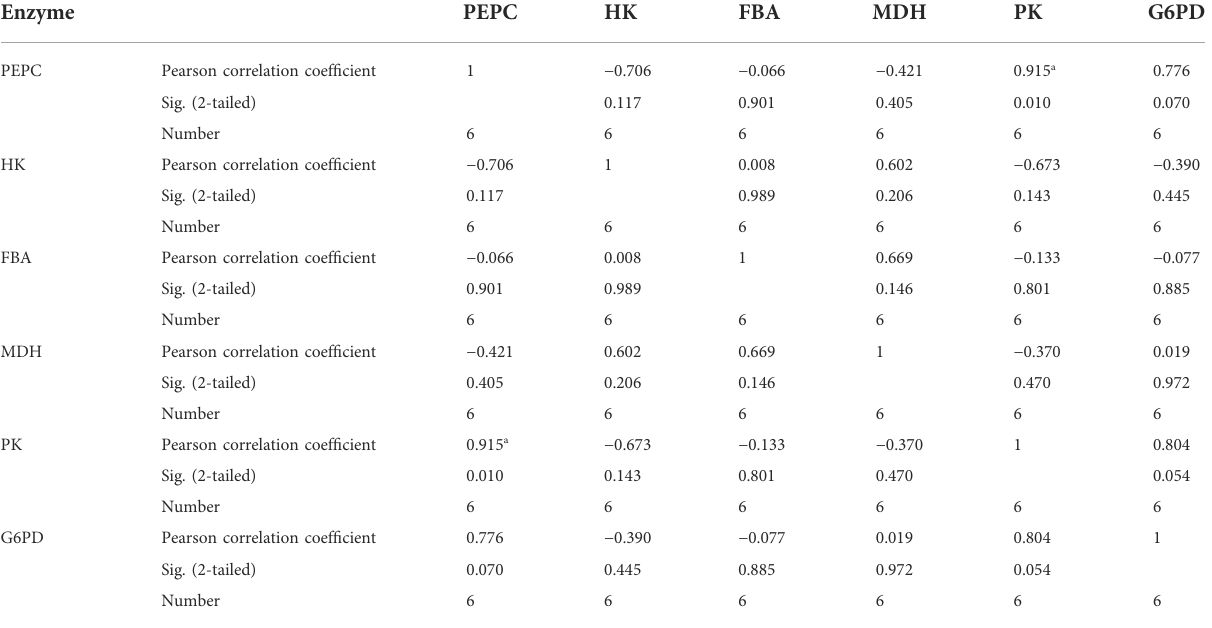
TABLE 2 Correlation analyses between variable enzymes. Enzyme PEPC